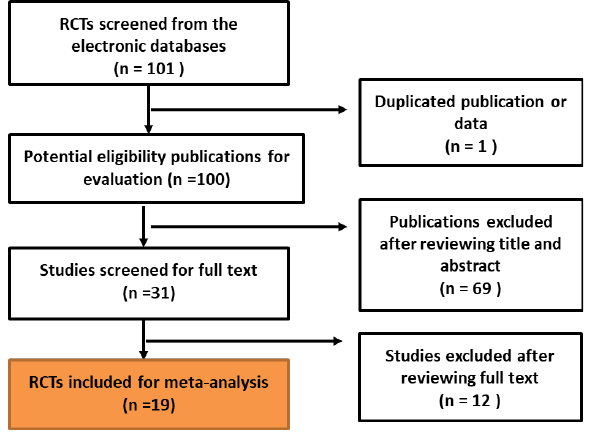
Figure 1: Flow diagram of the search strategy to identify relevant articles for inclusion.( RCTs, Randomized Controlled